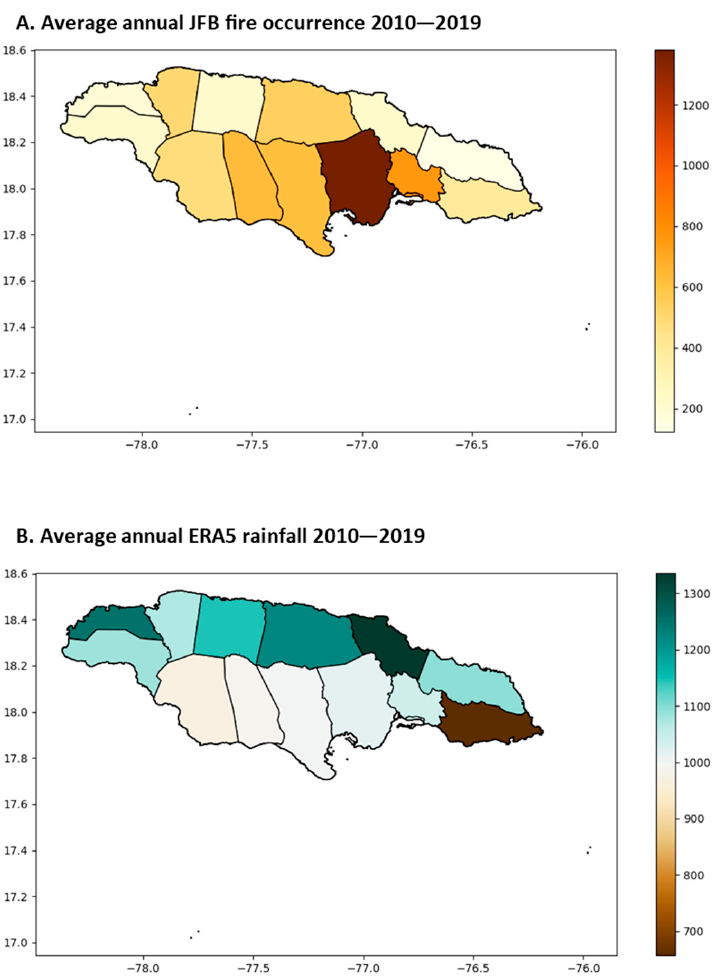
Figure 3. ( A ) Average annual number of fire occurrences (JFB) and ( B ) ERA5 average rainfall total (mm) over Jamaica for 2010–2019.